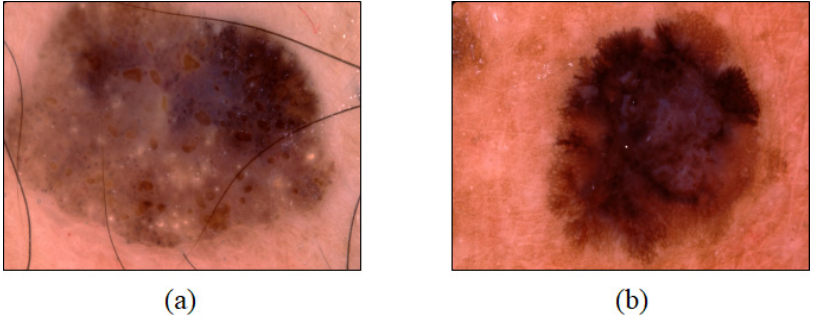
Figure 1. Dermoscopy images of ( a ) malignant melanoma and ( b ) a benign skin tumor (seborrheic keratosis).